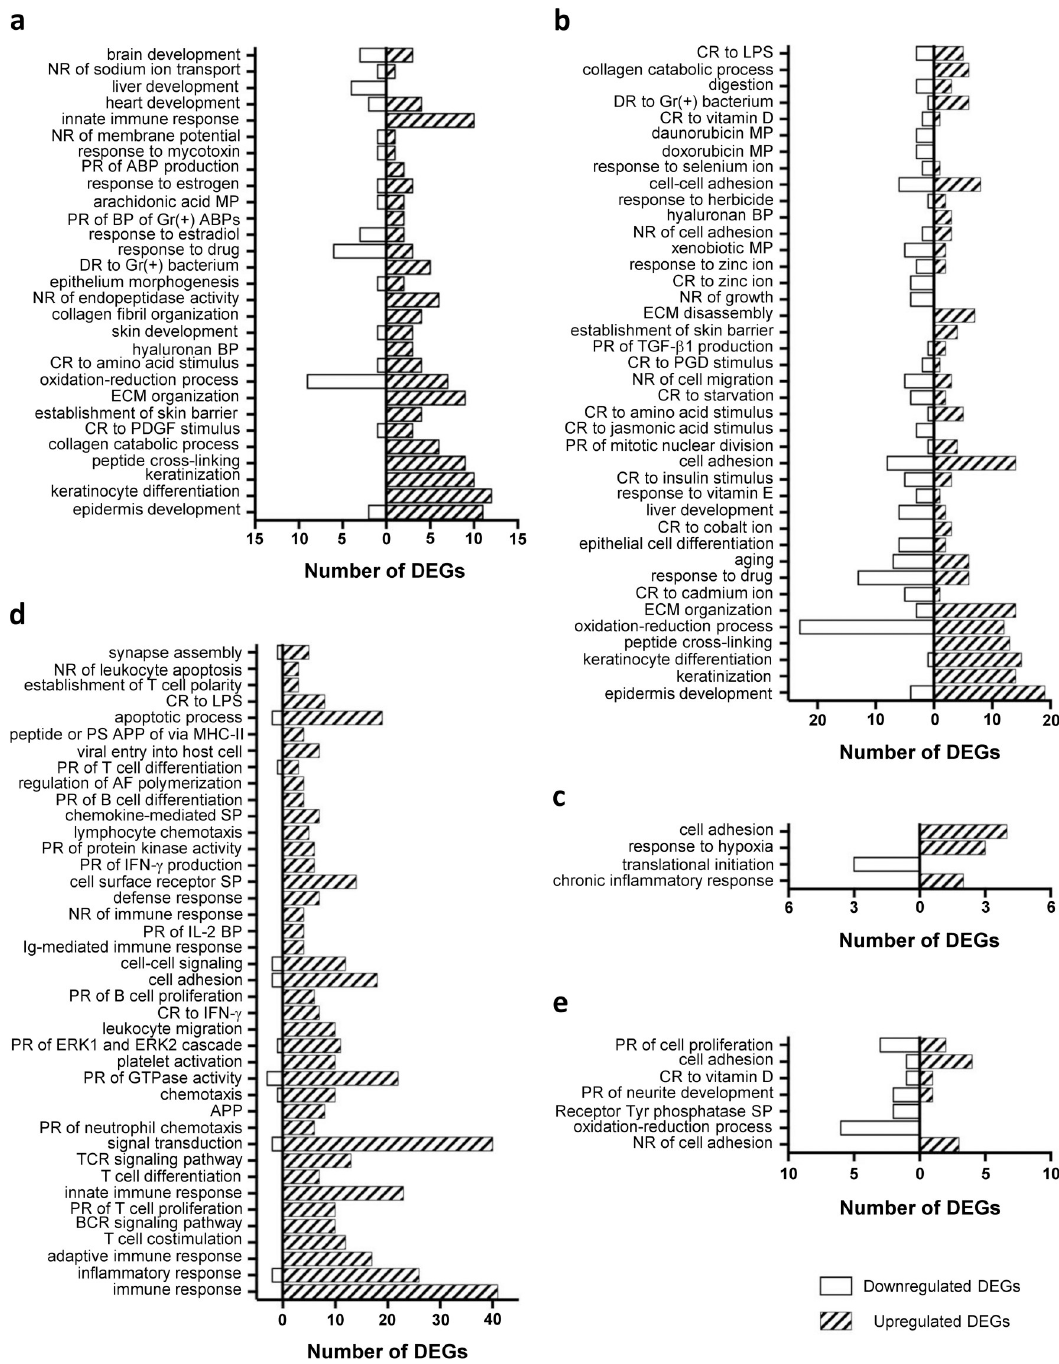
Fig 2. GO biological process terms enriched in DEGs. (a) GO terms enriched in the epithelium whole dataset. (b) Top 40 GO terms enriched in the epithelium partial dataset. (c) GO terms enriched in the mucosa whole dataset. (d) Top 40 GO terms enriched in the mucosa partial dataset. (e) GO terms enriched in the overlapping DEGs between the two partial datasets. The GO terms are ordered with the smallest p -value from the bottom of each graph. ABP: antibacterial peptide, AF: actin filament, APP: antigen processing and presentation, BP: biosynthetic process, CR: cellular response, DR: defense response, ECM: extracellular matrix, LPS: lipopolysaccharide, MP: metabolic process, NR: negative regulation, PDGF: platelet-derived growth factor, PGD: prostaglandin D, PR: positive regulation, PS: polysaccharide, SP: signaling pathway.